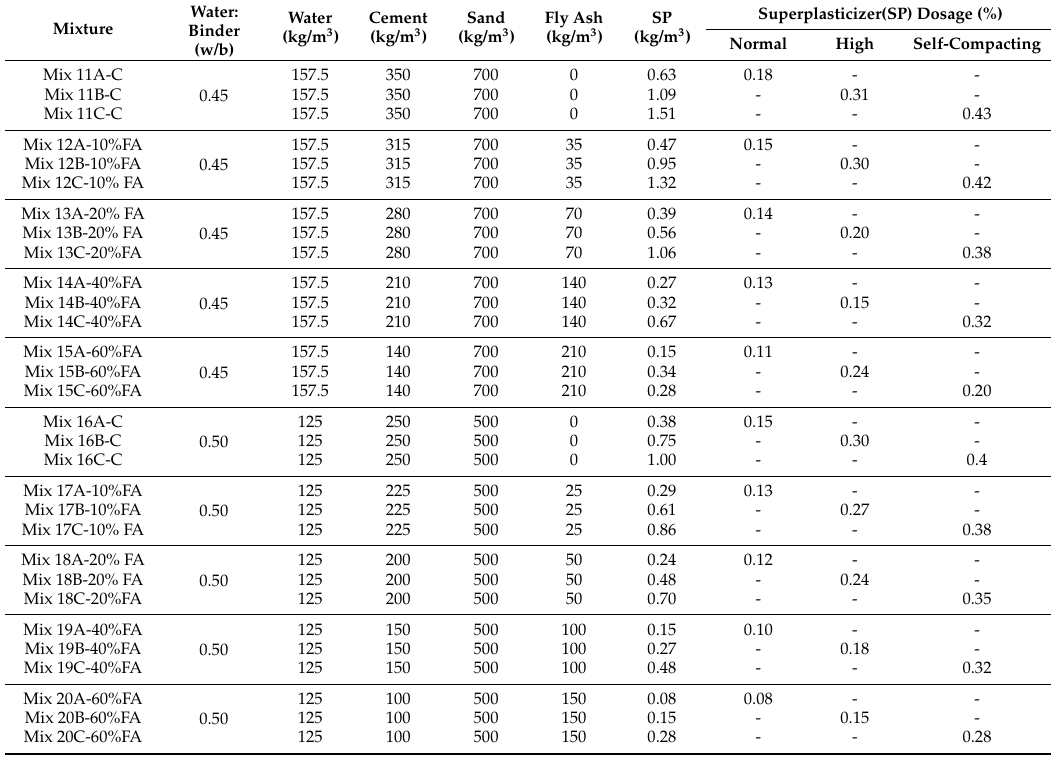
Table 2. Mix proportion w/b 0.45 and